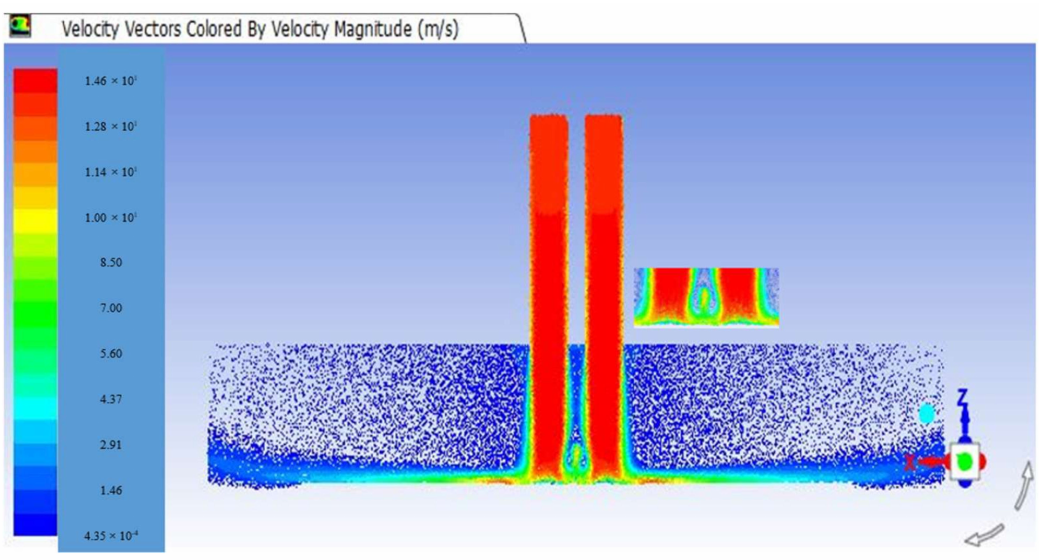
Figure 17. Velocity vectors colored by the velocity magnitude for the twin impingement jet mechanism at the Nozzle-Nozzle spacing equal to 1 cm and the Nozzle-Plate distance equal to 6